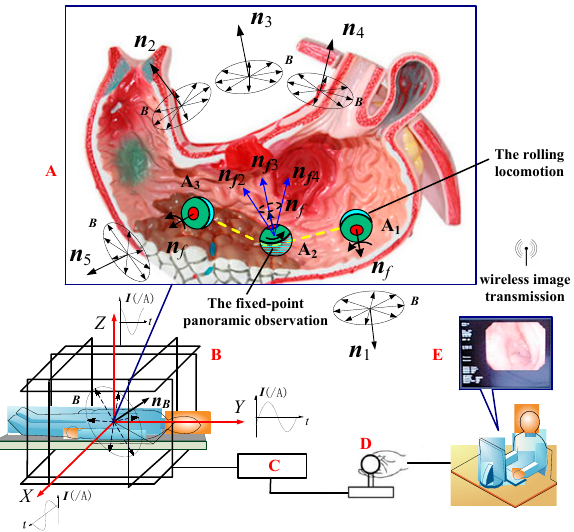
Figure 2. Application scenario of the DSCR and the control system of the universal rotating magnetic field (URMF). A: Double working mode of the DSCR: The fixed-point panoramic observation in the passive mode ( n 2 , n 3 , n 4 ); The rolling locomotion in the active mode ( n 1 , n 5 ). B: The tri-axial orthogonal square Helmholtz coils (TOSHC). C: The URMF controller. D: The Joystick. E: The interactive interface.